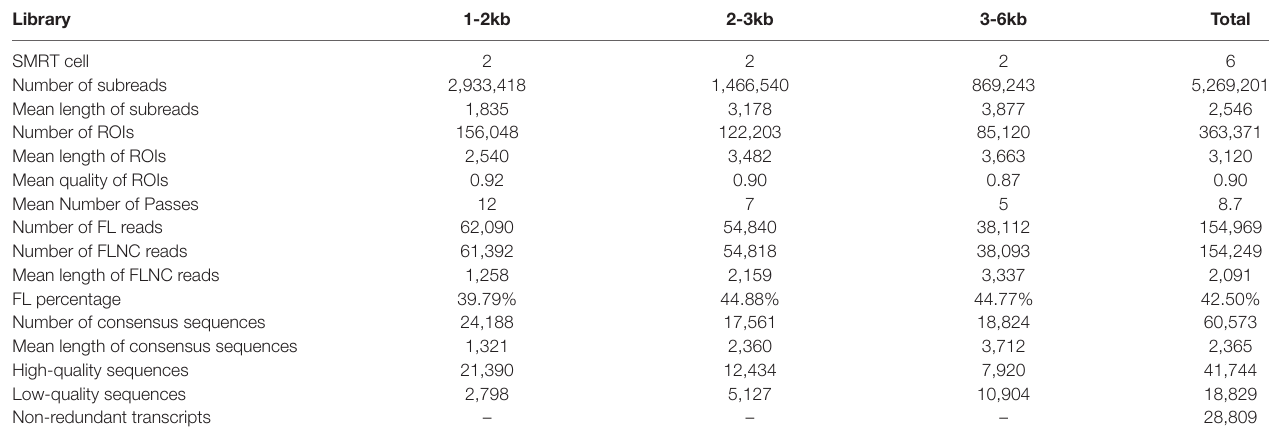
TaBLe 1 | Statistics of Iso-Seq data in L.